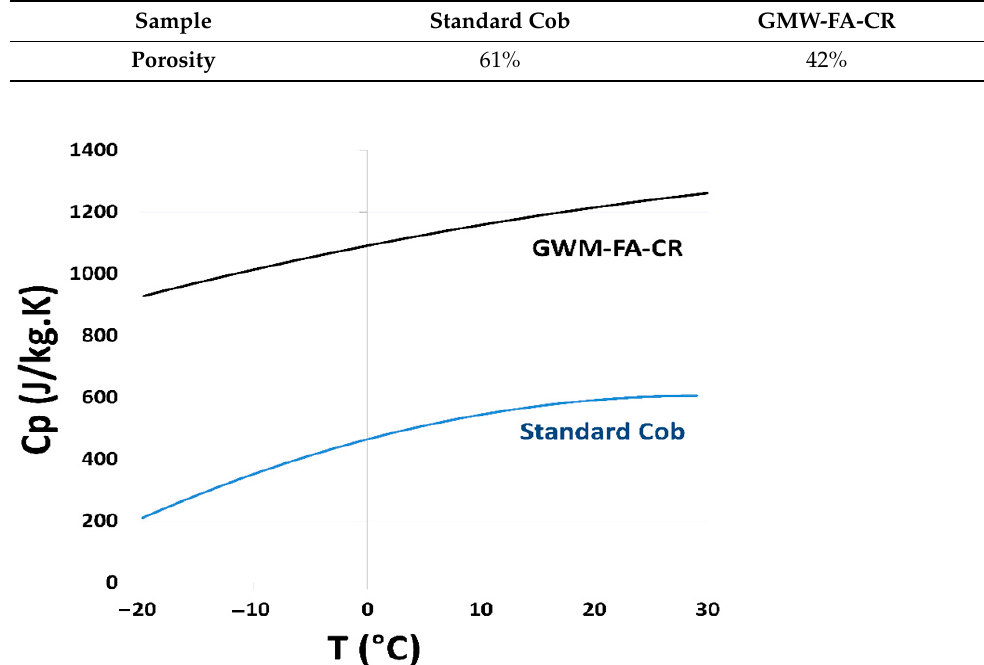
Figure 9. The variation in the specific heat capacity of the GWM-FA-CR mix and a standard cob material between − 20 °C and 30 °C. 3.2.8. Thermal Insulating Wall with GWM-FA-CR There is a strong tradition for cob constructions in Germany [75]. This system of con- struction is made with a secondary layer. The first layer is composed of traditional cob as